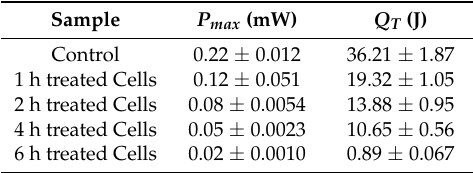
Table 1. Metabolic parameters for the M. aeruginosa cells by nano-TiO 2 mediated